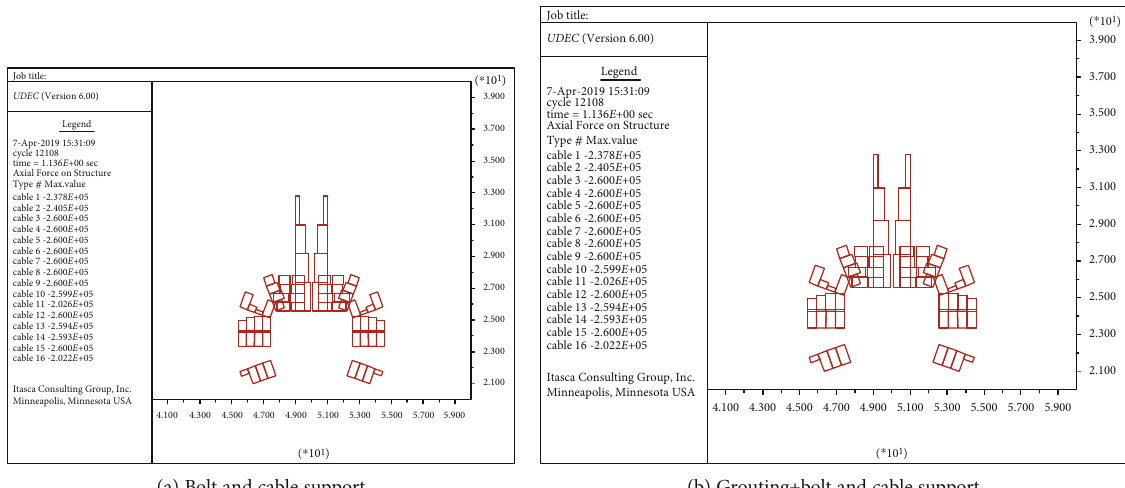
Figure 8: Stress state of roadway support structure.